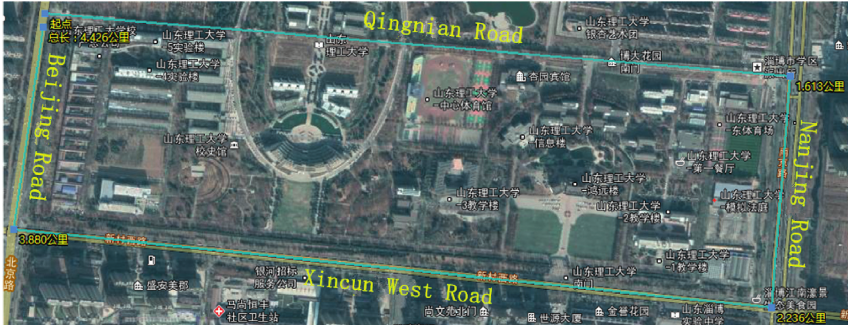
Figure 2: Real driving experimental route.